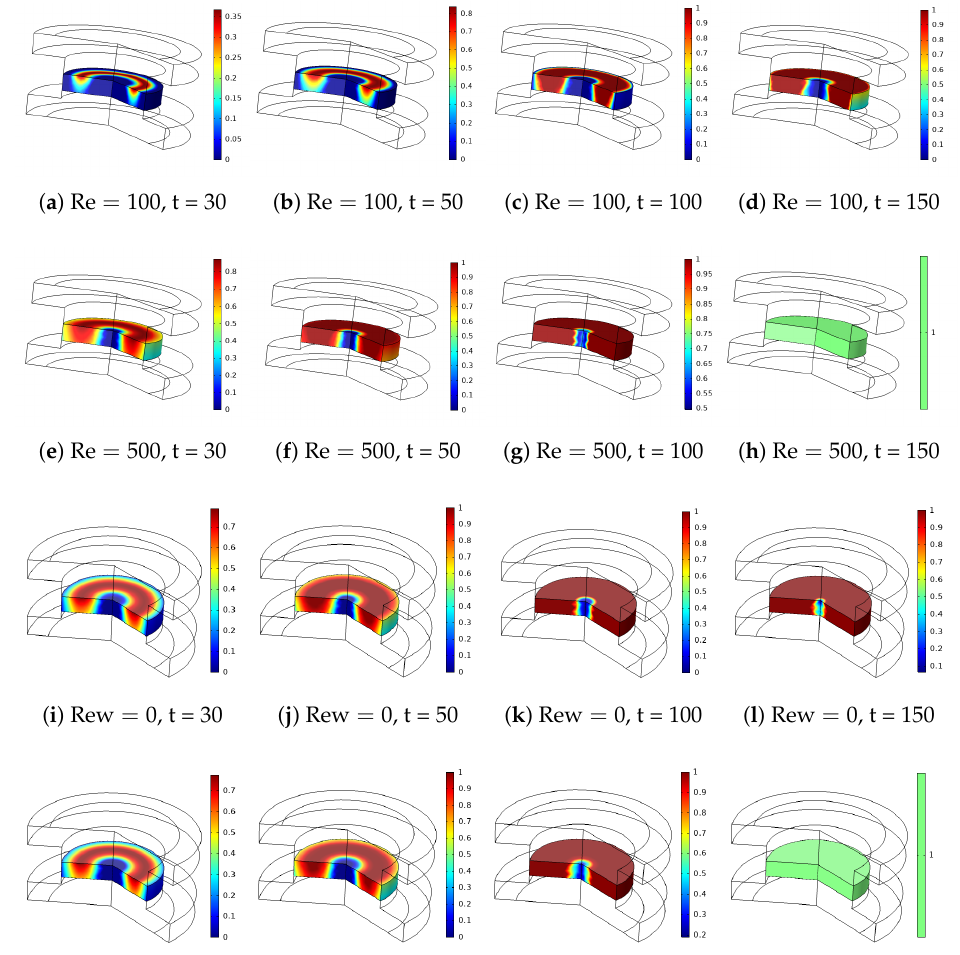
Figure 6. Distribution of liquid fraction (Lq) with varying fluid stream Re number (Rew = 500, ( a )–( h )) and rotational Re number (Re = 300, ( i )–( p )) at various time instances (t in minutes) ( di = 0.25 L 1, L 0 = 0.6 L 1, yp = 0.1 H, NC =